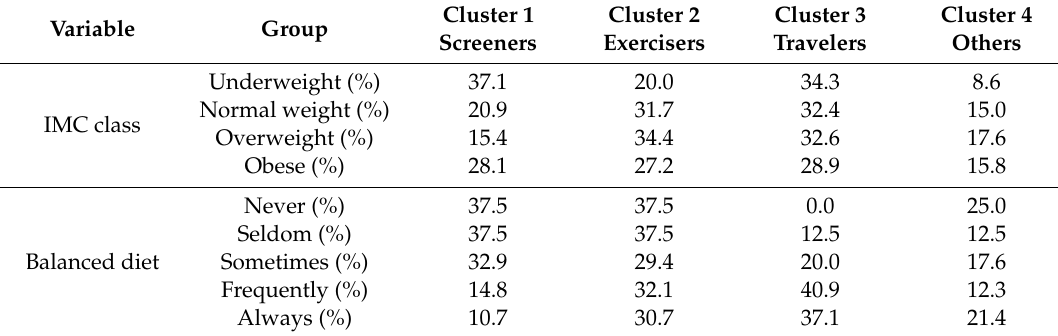
Table 11. Cluster membership according to some anthropometric and lifestyle